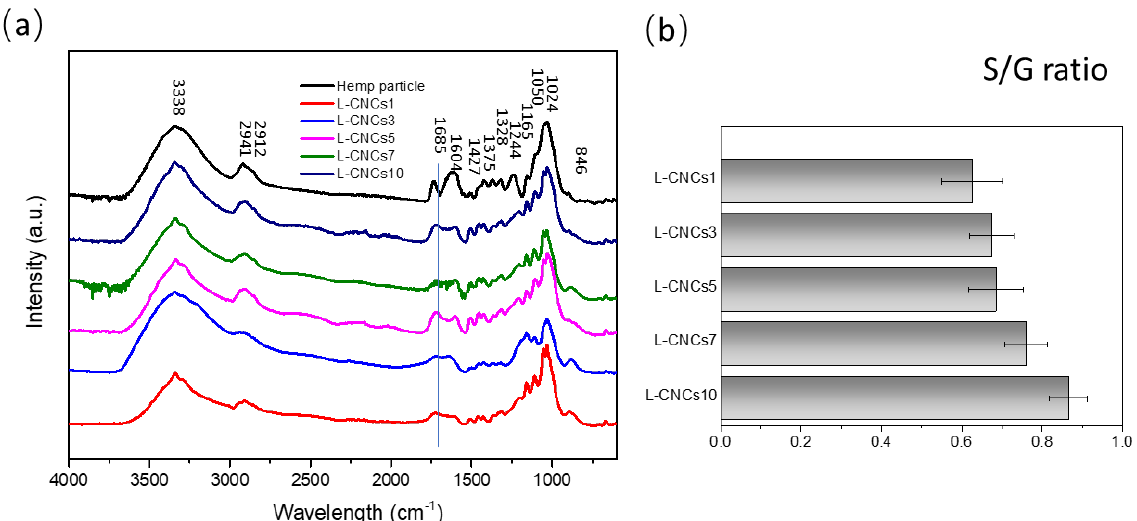
Figure 4. ( a ) FTIR spectrum of hemp particle and L-CNCs. ( b )The ratio of syringyl to guaiacyl (S/G) in the samples represented by I 1328 /I 1244 .